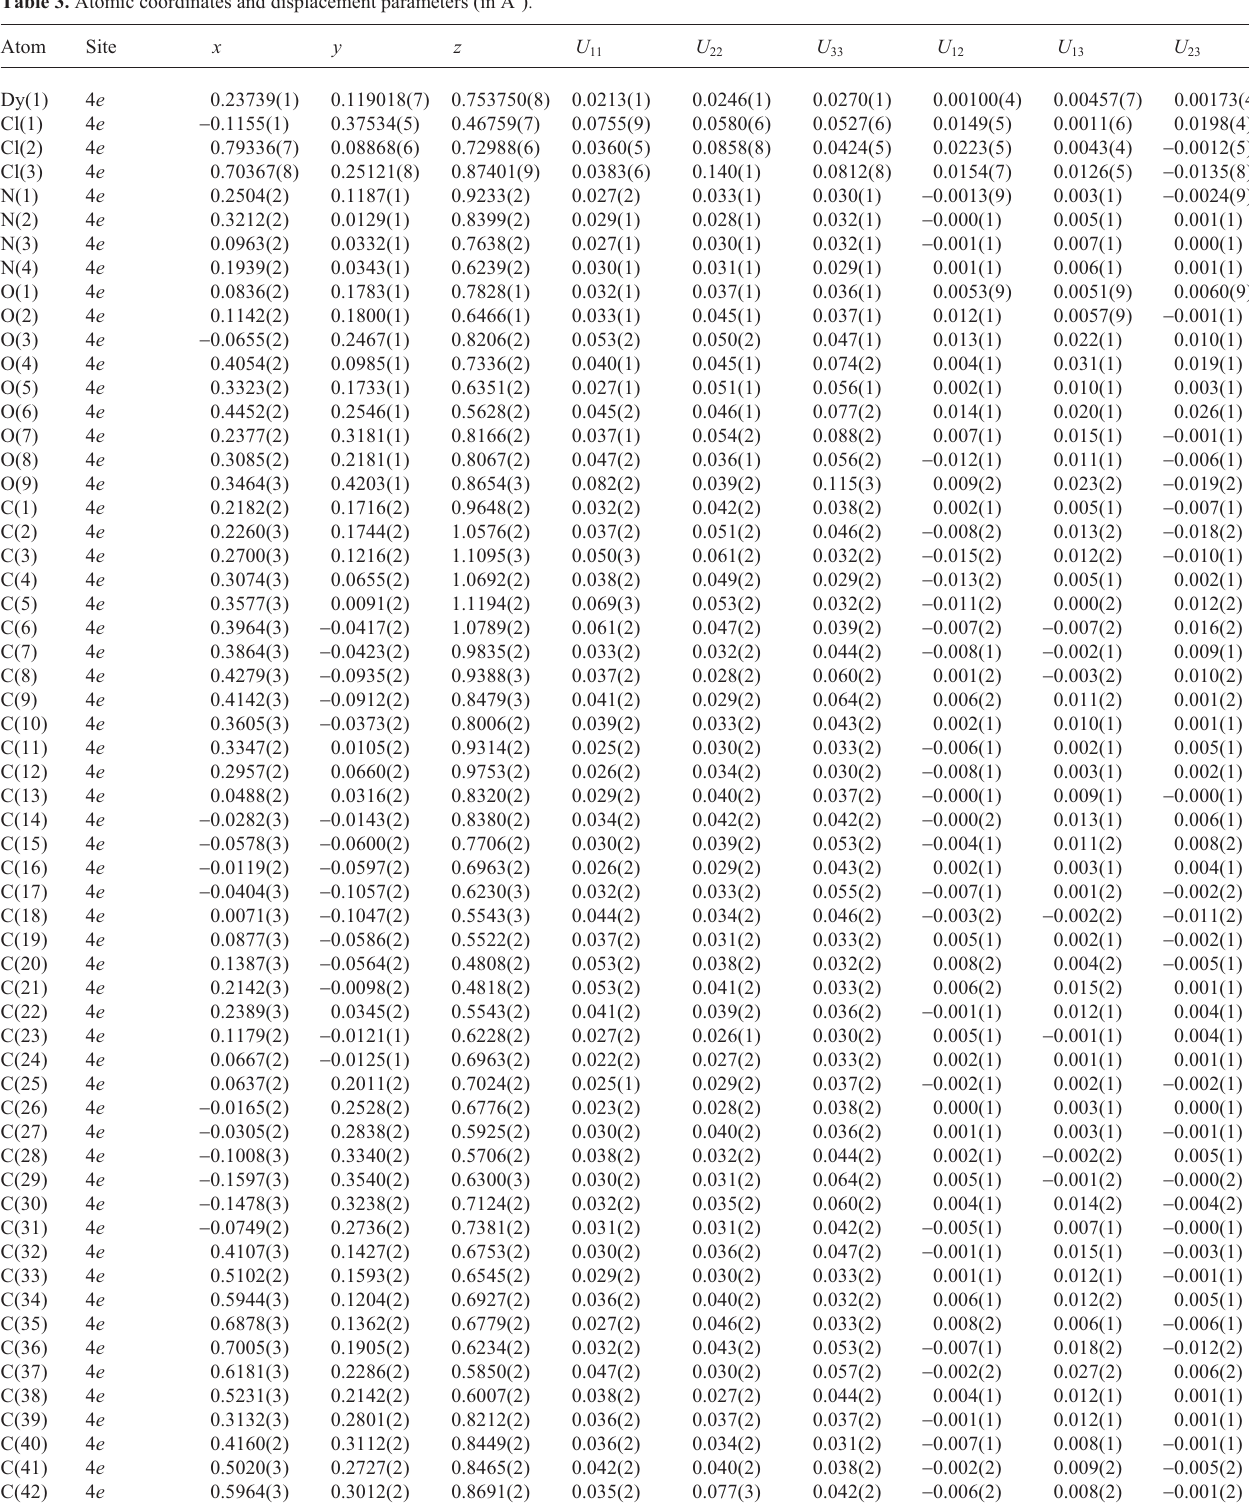
Table 3. Atomic coordinates and displacement parameters (in Å 2 )